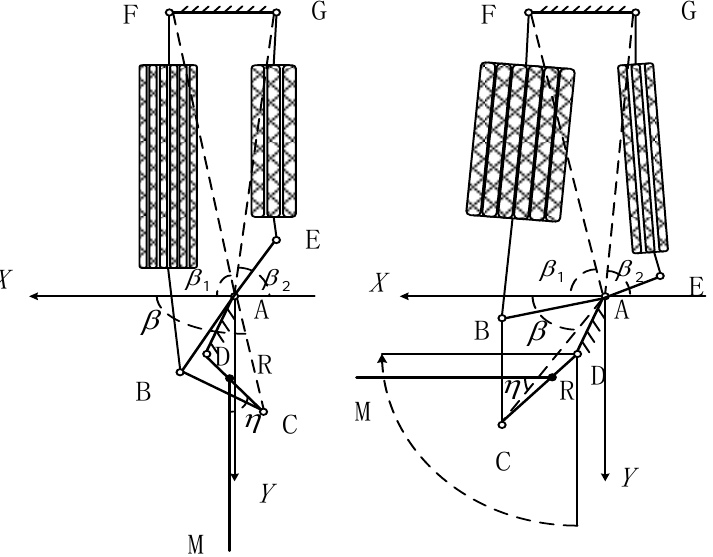
Figure 2. Sketch of the structure of a four-link elbow joint.